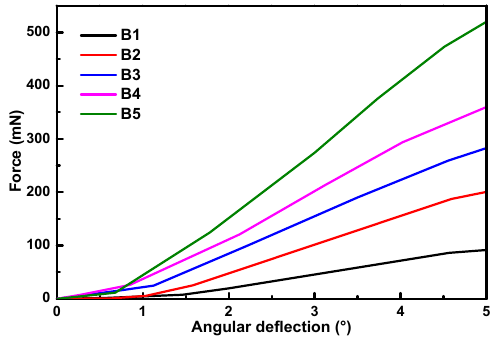
Materials 2019 , 12 , x FOR PEER REVIEW Figure 5. Bending force versus angular deflection ( P- α ) of di ff erent layers of bamboo culm. Figure 5. Bending force versus angular deflection ( P- α ) of different layers of bamboo culm. Table 1. The physical and mechanical properties of bamboo slivers under different bending Types.